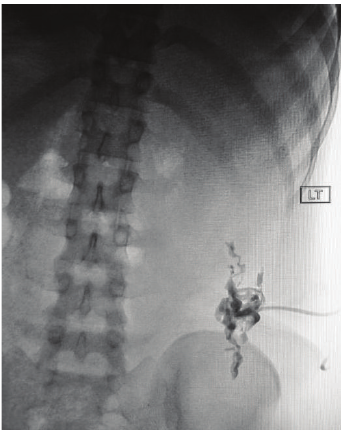
Figure 3: X-ray fluoroscopy confirming placement of colonic abscess